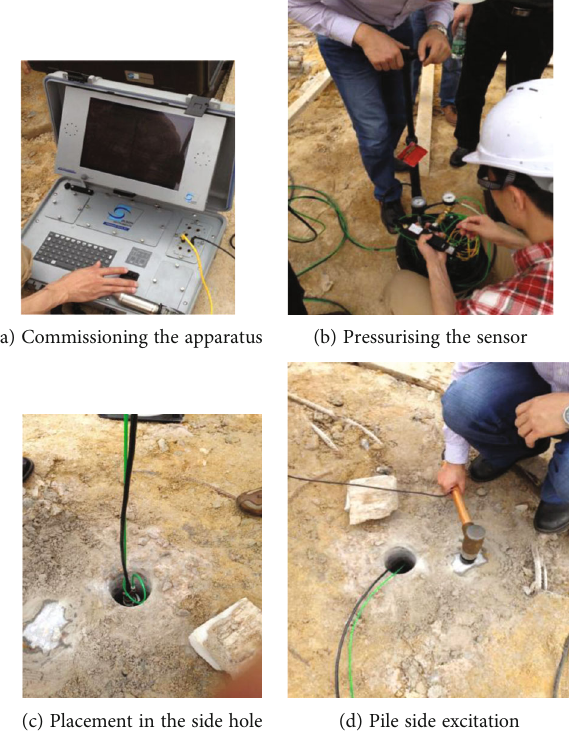
Figure 12: Parallel seismic wave method fi eld testing